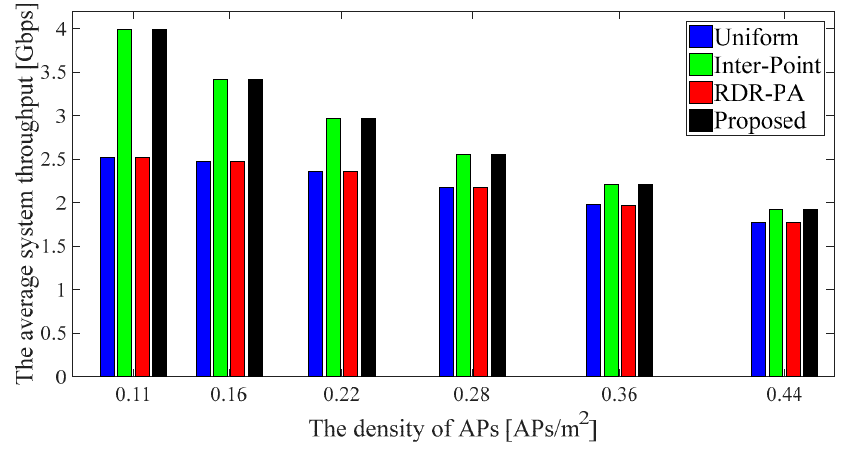
Figure 5. The average system throughput versus the density of access points.